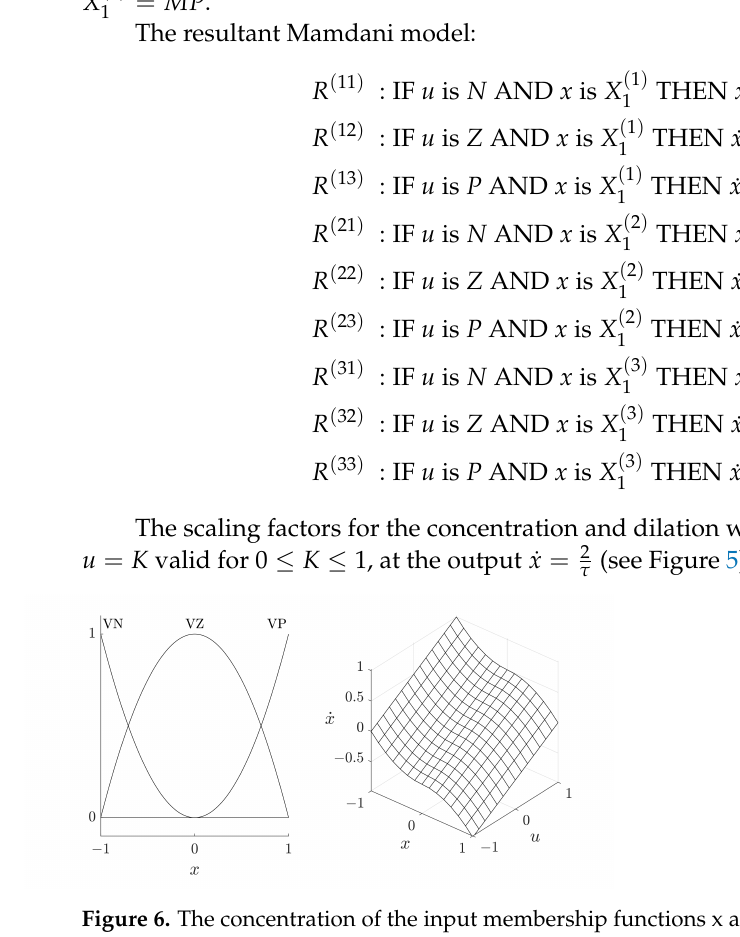
Figure 6. The concentration of the input membership functions x and the resulting inference